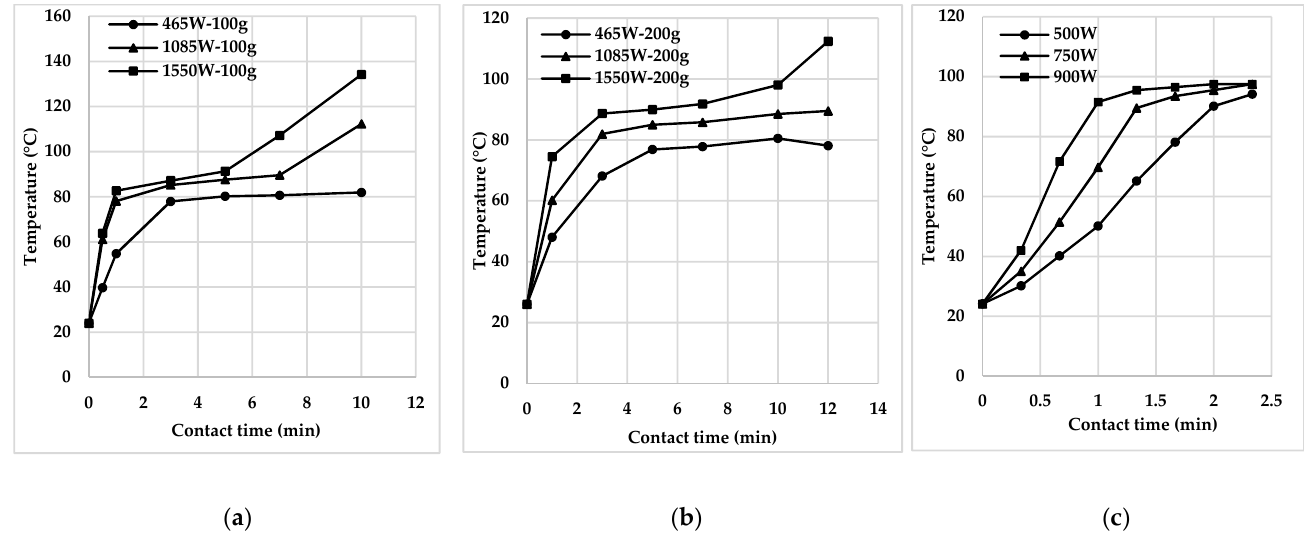
Figure 2. Dependence of temperature on the time of MW-heating of: ( a ) faecal sludge in Kenya, 100 g sample [27]; ( b ) faecal sludge in Kenya, 200 g sample [27]; and ( c ) active sludge in China Reprinted with permission from ref. [25].